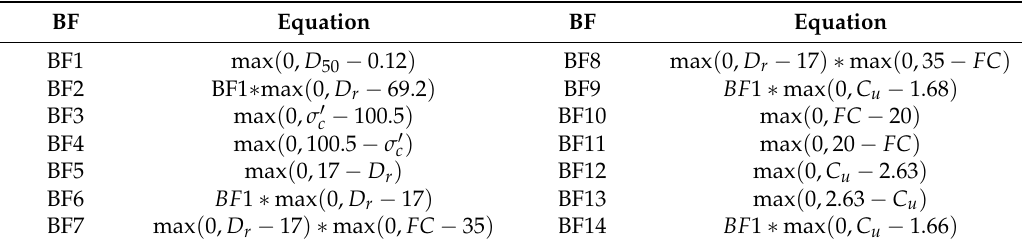
Table A1. Expressions of Equation